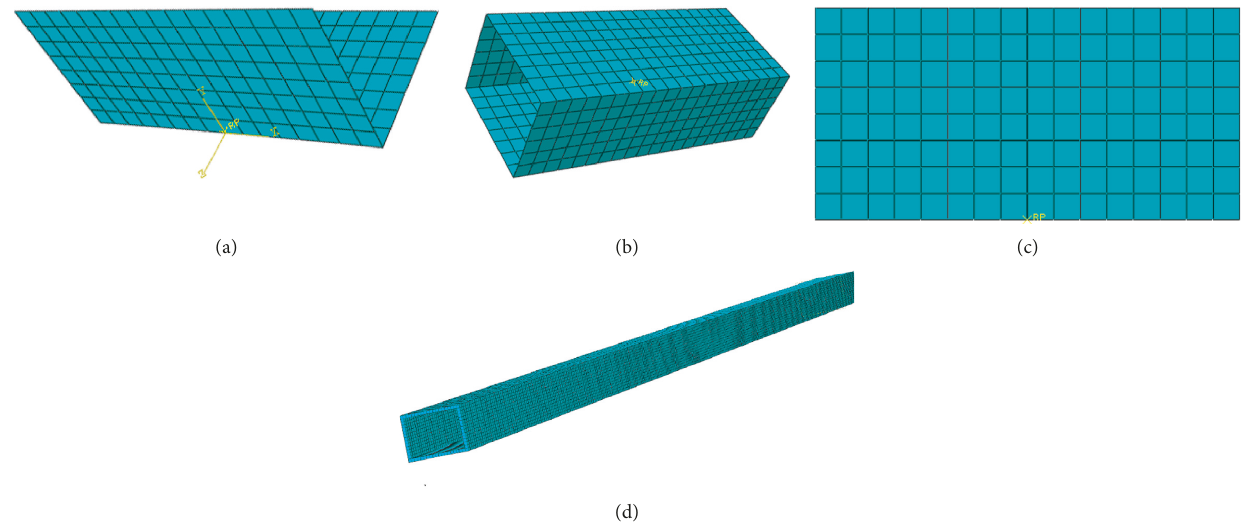
Figure 7: Parts diagram: (a) horizontal die; (b) clamp; (c) horizontal die; (d) profile.